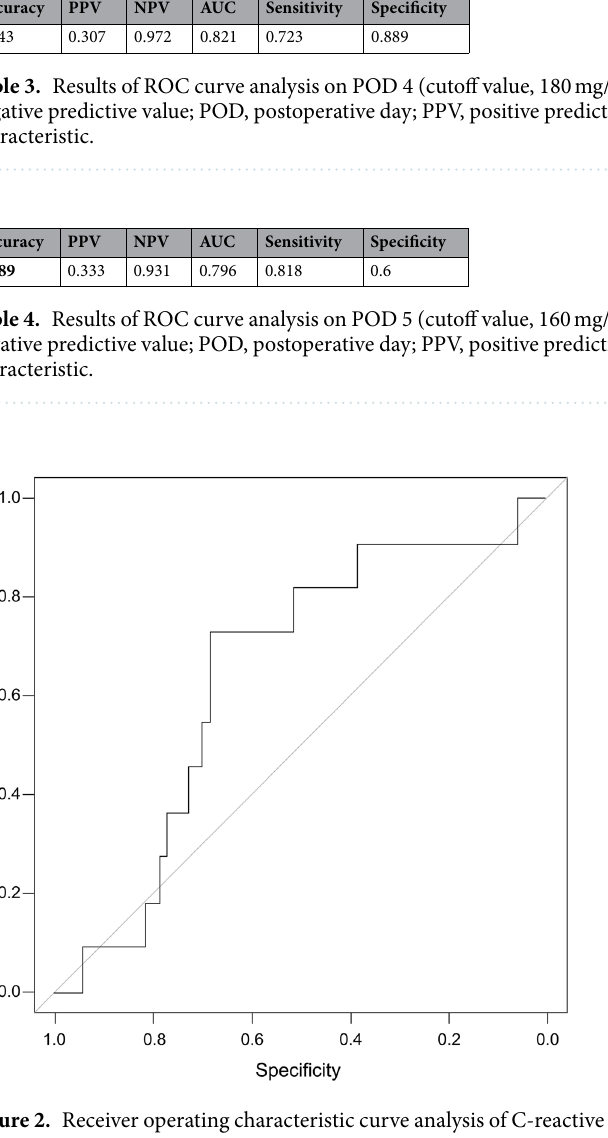
Figure 2. Receiver operating characteristic curve analysis of C-reactive protein level on postoperative day 3.